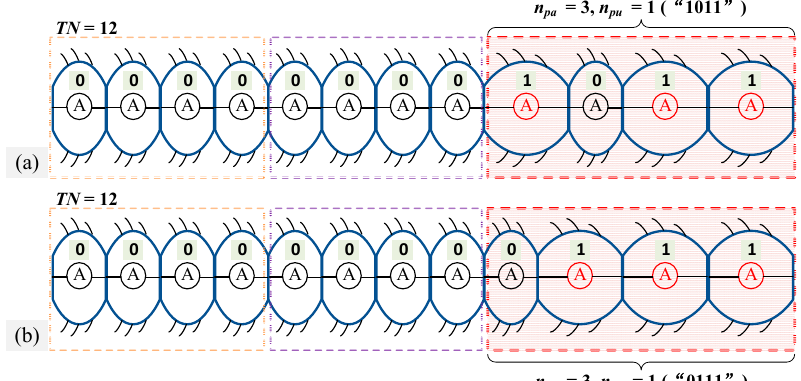
Figure 4. The initial distribution of the B-DM with four segments for a 12-segment earthworm-like locomotion robot. ( a ) A broken, nonactuated body segment exists in the driven module (“1011”). ( b ) The nonactuated body segment is located at the boundary of the driven module (“0111”).